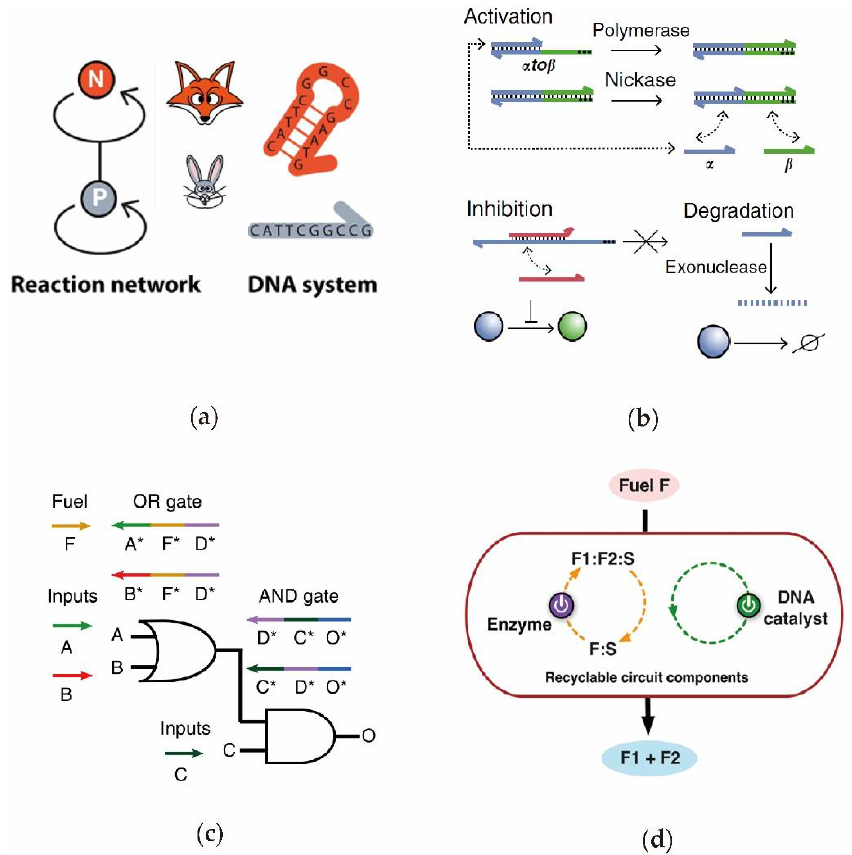
Figure 4. Designs of biological enzyme-involved DNA circuits. ( a ) Schematic diagram of the DNA logic gates using strand displacement polymerase. ( b ) Highly efficient dual-catalytic recyclable DNA circuit driven by nicking enzyme and DNA catalyst. ( c ) Schematics for the oscillating DNA circuit based on protein enzyme. ( d ) The enzyme-toolbox-directed DNA circuit with activation, inhibition, and subtraction functions.